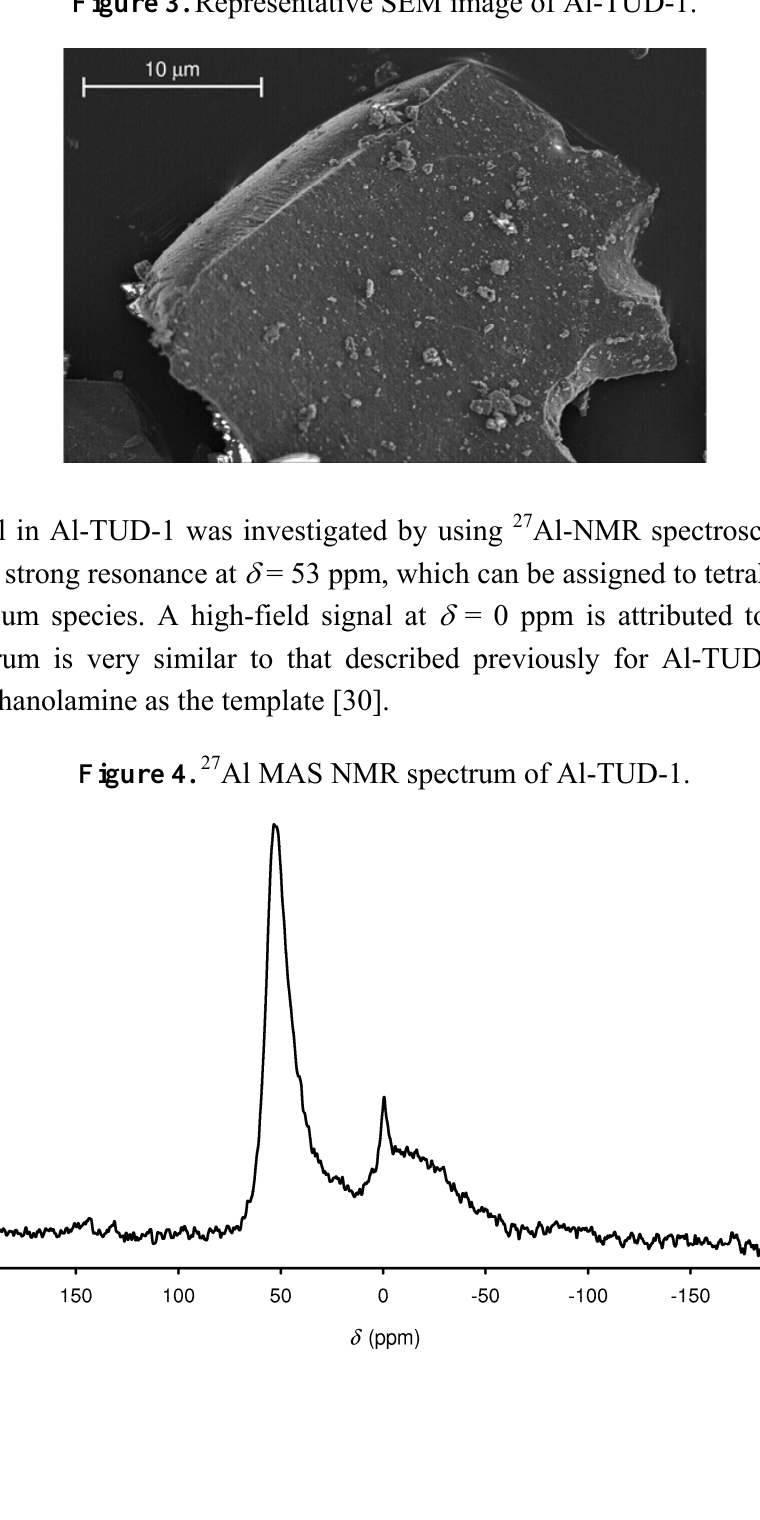
Figure 3. Representative SEM image of Al-TUD-1.